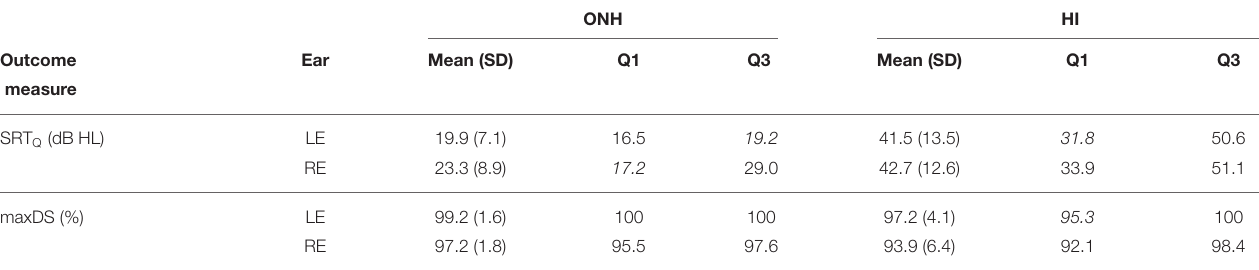
TABLE 6 | Summary of the results of the word recognition scores (WRS-4UFC) test.